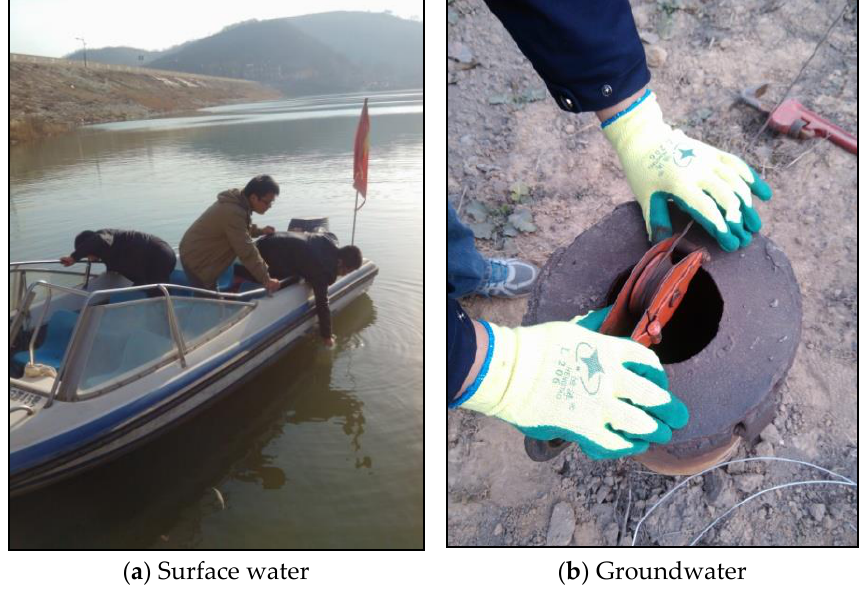
Figure 2. Field Sampling.